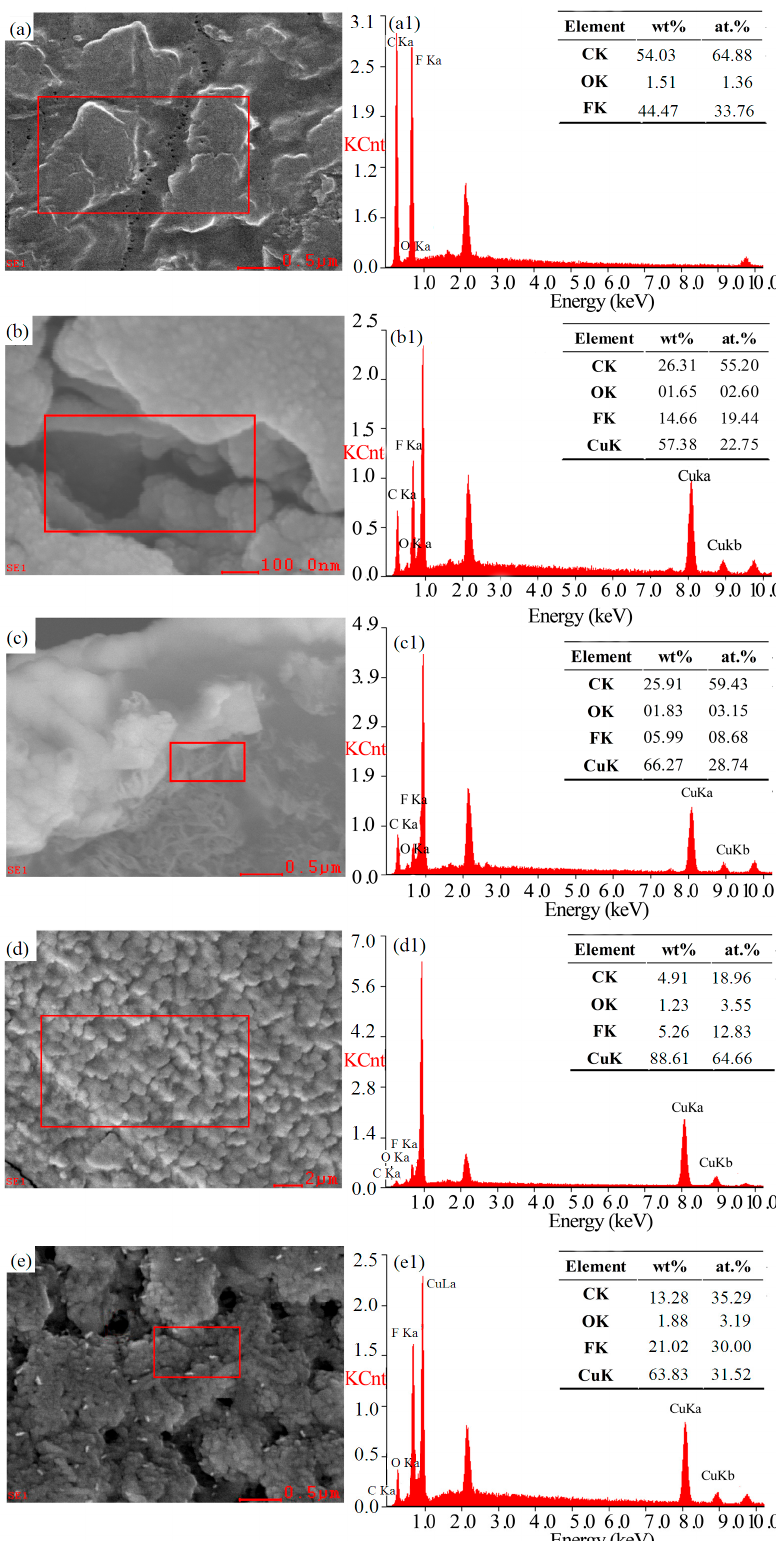
Figure 3. Chemical elemental composition measured using EDX for M0 ( a , a1 ), M15 ( b , b1 , c , c1 ), and M45 ( d , d1 , e , e1 ): ( a , b , d ) surface morphology, ( a1 , b1 , d1 ) elements on the surface, ( c , e ) cross-section morphology, and ( c1 , e1 ) elements at the cross-section near the surface.